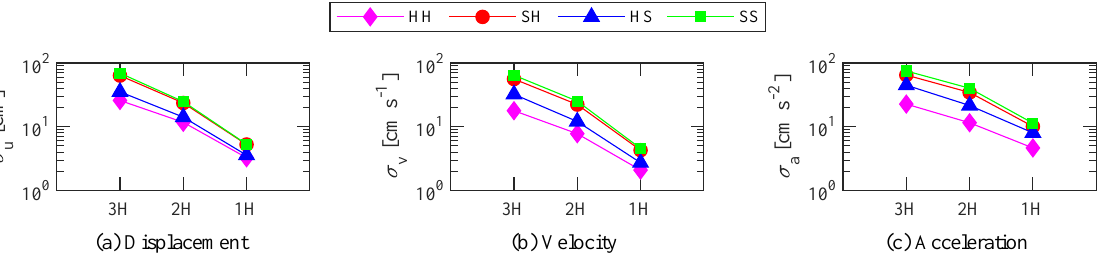
Figure 16. Standard deviation of wind-induced displacement, velocity, and acceleration of the FD system. 1H, 2H, and 3H are types of frame, and HH, SH, HS, and SS are types of added components of systems, which is indicated in Table 1